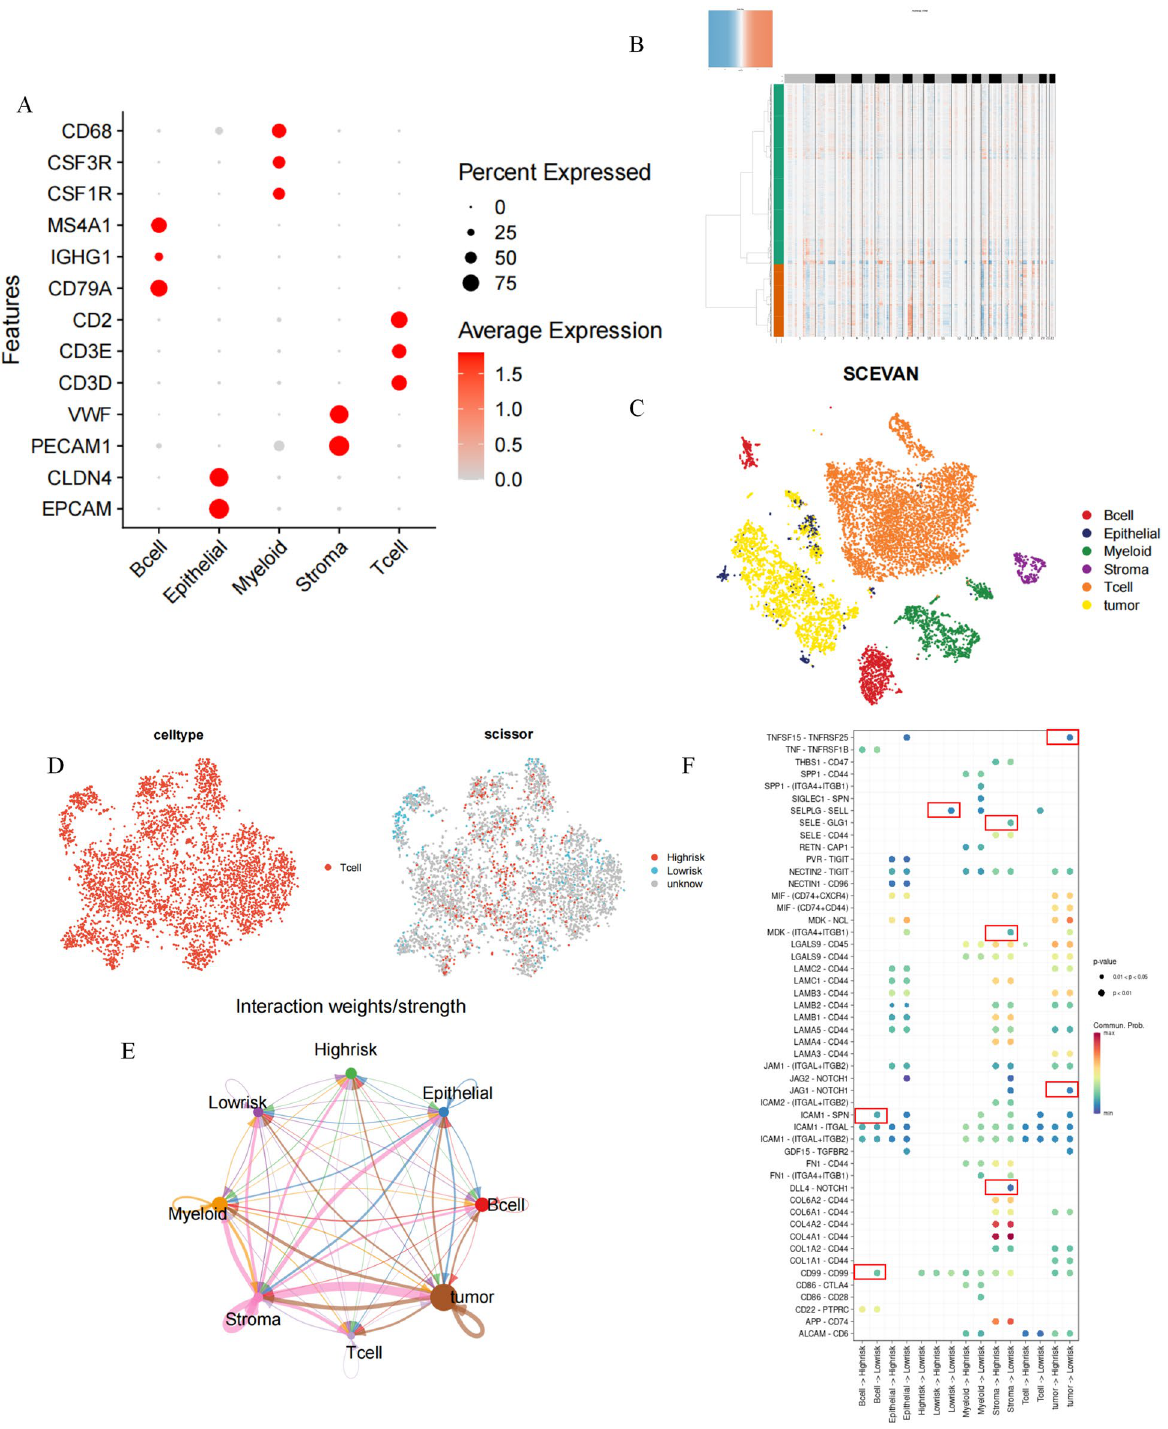
Figure 5. Single-cell analysis of IRS. ( A ) Expression of cellular annotated genes. ( B ) Copy number changes in tumor cells and normal cells. ( C ) Cell types after annotation of all cells. ( D ) Identification of high-risk and low- risk T cells. ( E ) Cellular communication analysis of the landscape. ( F ) Analysis of ligand-receptor interactions between different cell